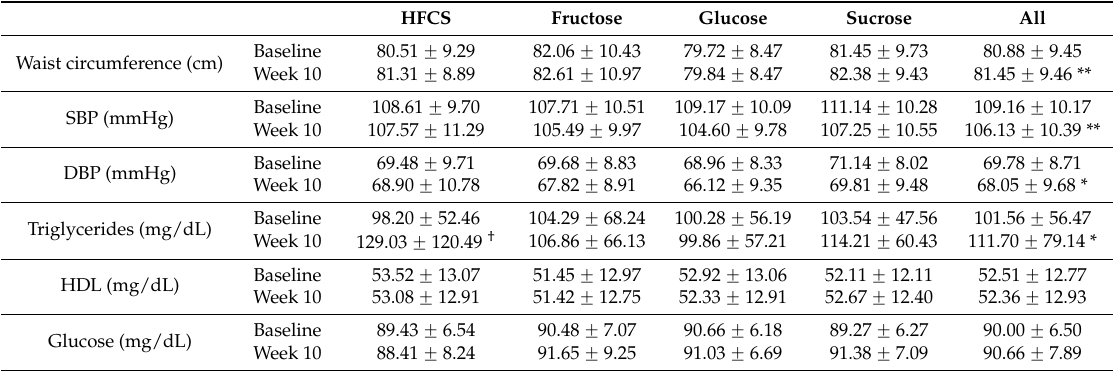
Table 2. The effect of ten weeks of daily consumption on each of 4 different types of sugar on diagnostic criteria for the Metabolic Syndrome.